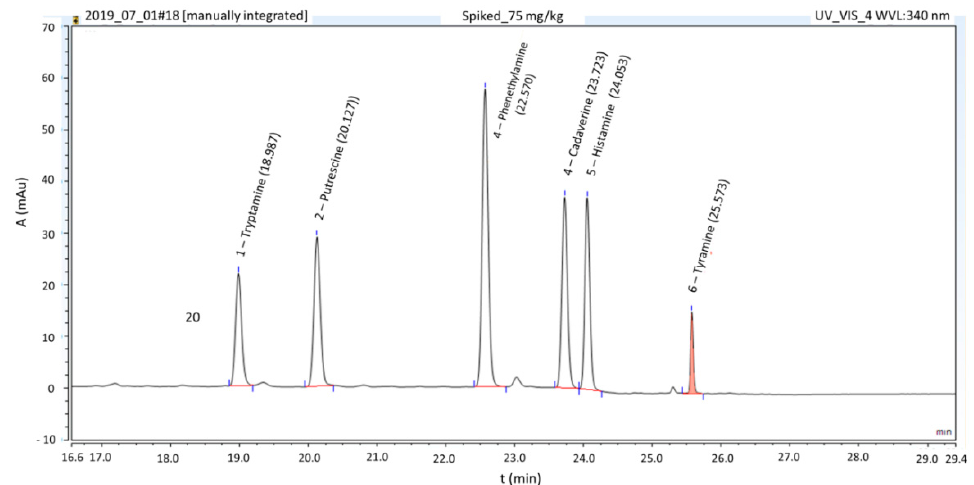
Figure 1. Representative chromatograms of biogenic amines in a blank sample spiked with standard mixture at 75 mg kg − 1 concentration.